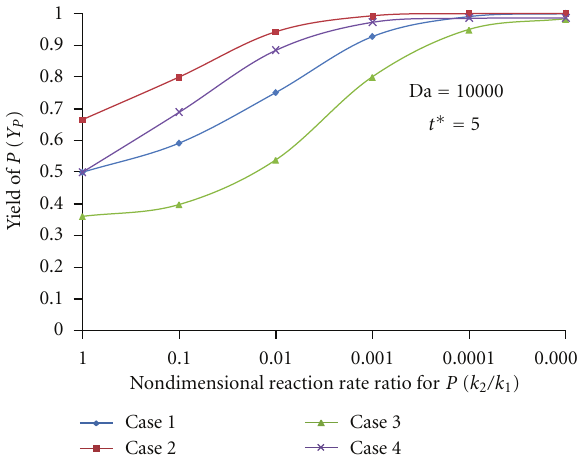
Figure 9: Plot of yield of P versus k 2 / k 1 for Da = 10000 at Da · t ∗ = 50000 for C-P cases.